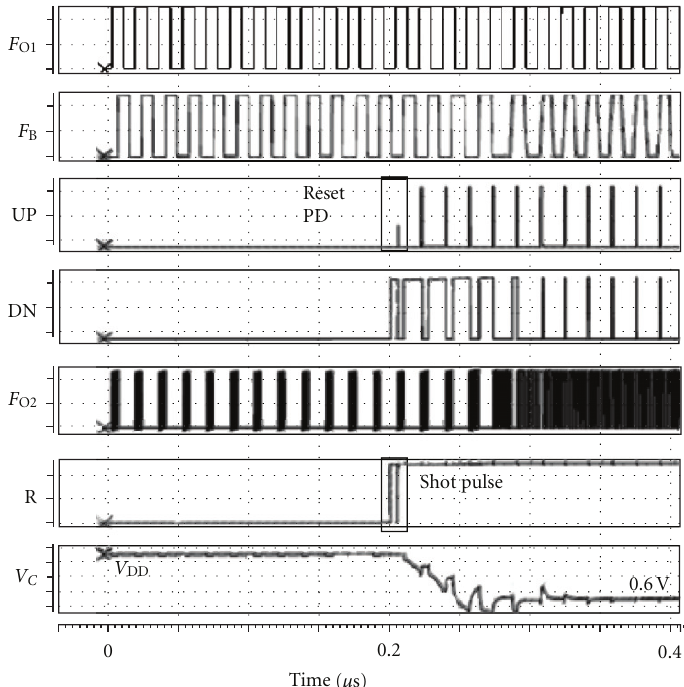
Figure 27: Postlayout simulation results from DLL2 locking operation. The simulation condition is tt/1.2V/25 ◦ C.